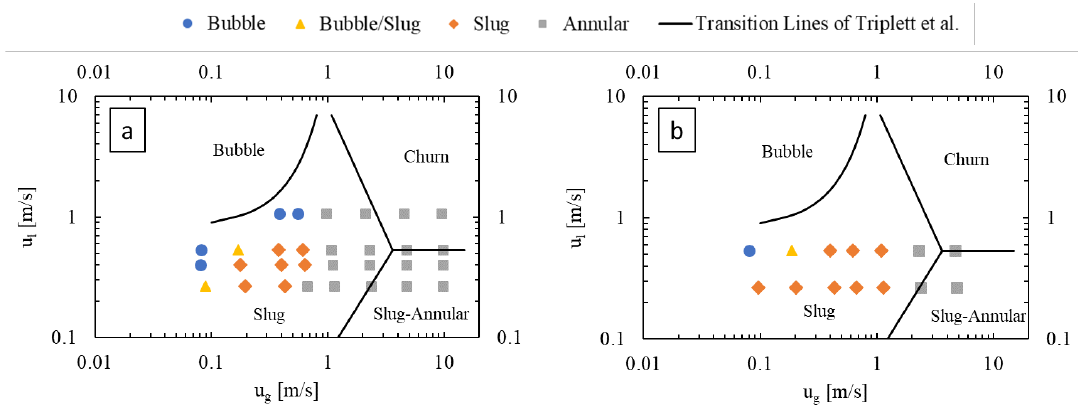
Figure 4. Flow regime maps of ( a ) LL-Rhombus and ( b ) LL-Triangle, with deionized water as liquid phase.